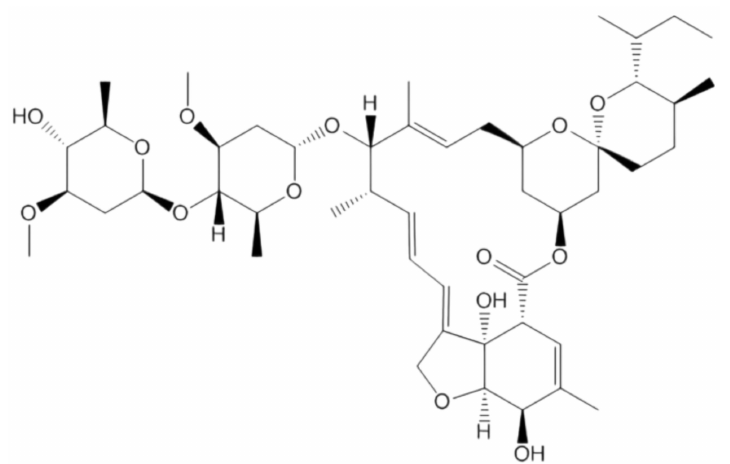
Figure 14. Structure of